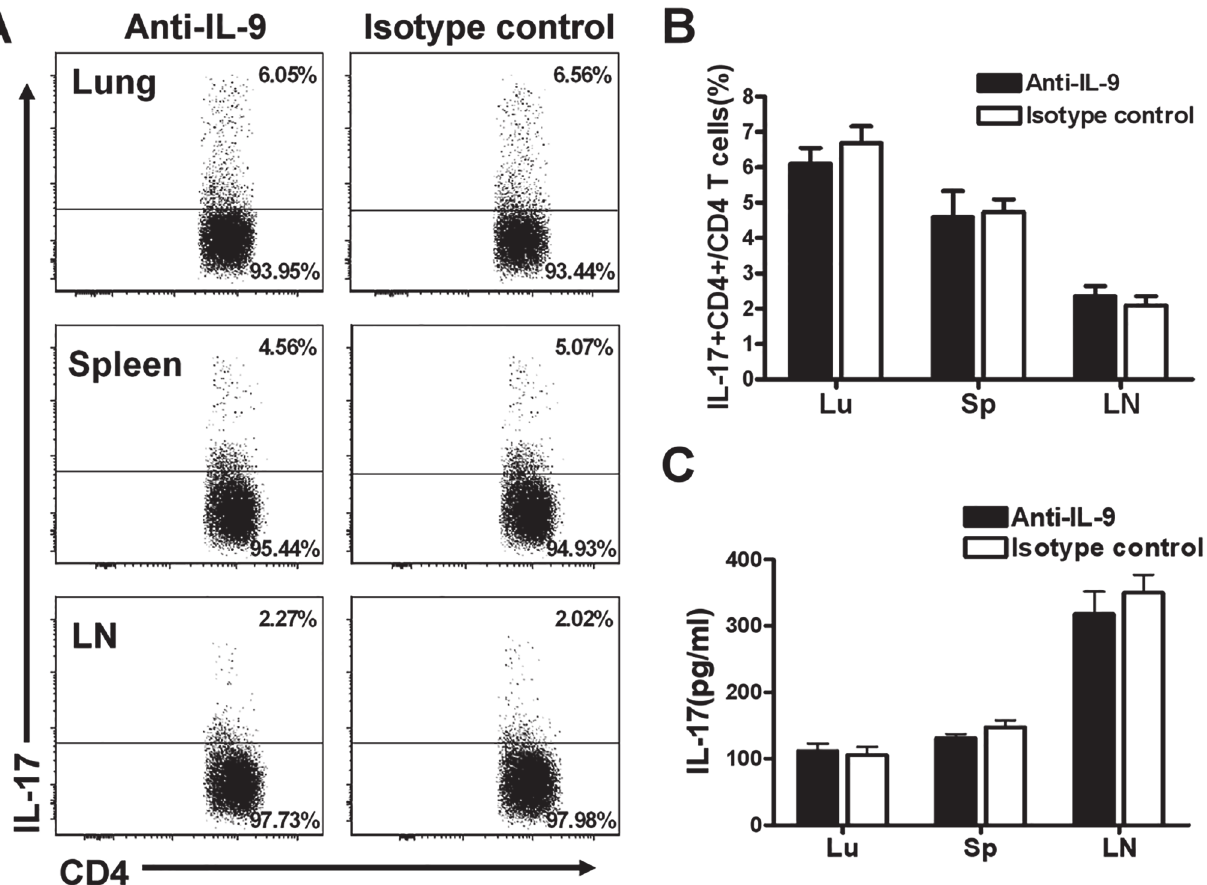
Fig 6. In vivo neutralization of IL-9 failed to alter IL-17/Th17 production following Cm lung infection. The mice were treated as described in legend to Fig. 5. On day 7 post-infection, lung, spleen and draining LN cells were isolated and analyzed by intracellular cytokine staining or cultured for 72 h following by ELISA testing of IL-17. (A) Representative staining of IL-17 producing CD4 cell in the lung, spleen and draining LNs; the percentages of IL-17-producing CD4+ T cells were showed in the right upper quadrant of the graph. (B)Summary of the percentage of IL-17 producing CD4 T cells in each group. (C) Lung, spleen and draining LN cells were cultured with stimulation of UV-inactivated Cm EBs, and IL-17 concentrations in 72h culture supernatants were determined by ELISA. Three independent experiments with four mice in each group were performed, and one representative experiment is shown. Data show the mean ±